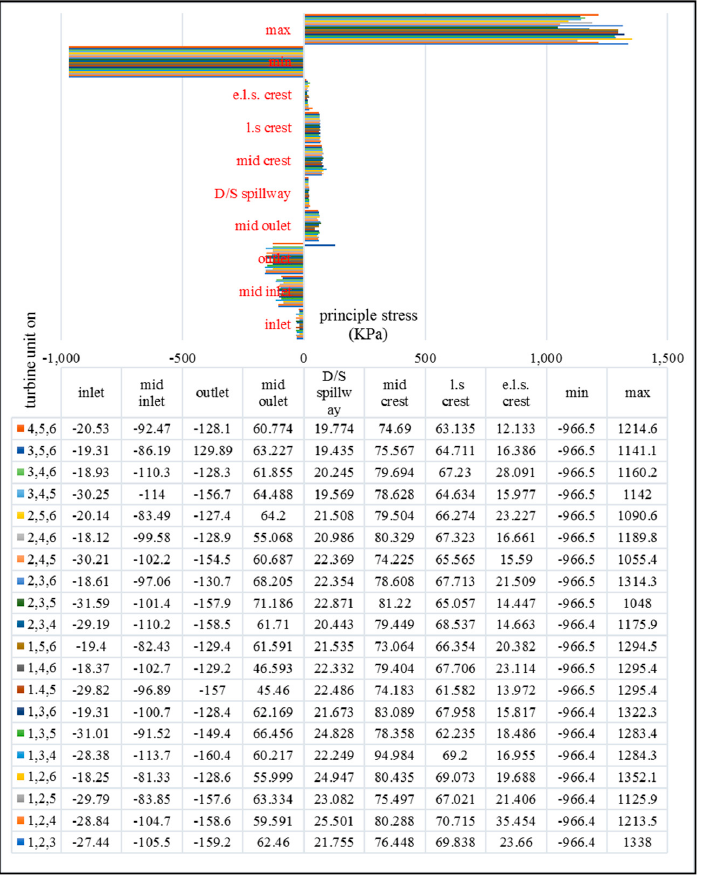
Figure 9. The principal stress values in the selected points of the Haditha dam body due to running three turbine units at a maximum upstream water level.